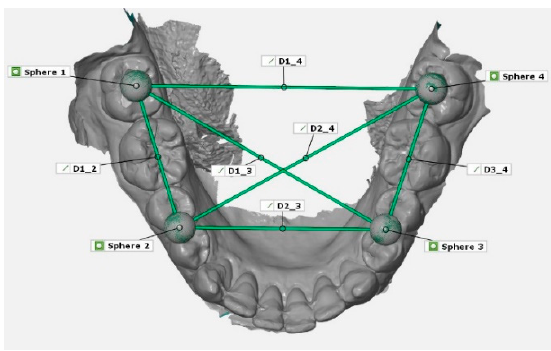
Figure 2. Example of the measurement of linear distances (D1_2, D1_3, D1_4, D2_3, D2_4, D3_4) between centers of the four spheres (1–4).